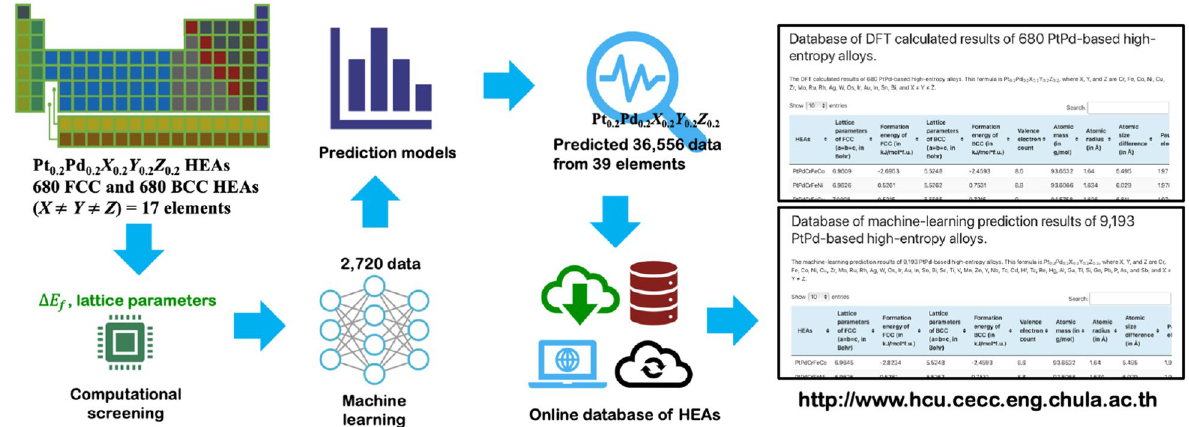
Figure 2. Our workflow based on first-principles density functional theory (DFT) and machine learning (ML) for the prediction of lattice parameter ( a ) and formation energy ( (cid:31) H f ) of HEA systems involving the utilization of our public database at http:// www. hcu. cecc. eng. chula. ac. th/ hea- datab